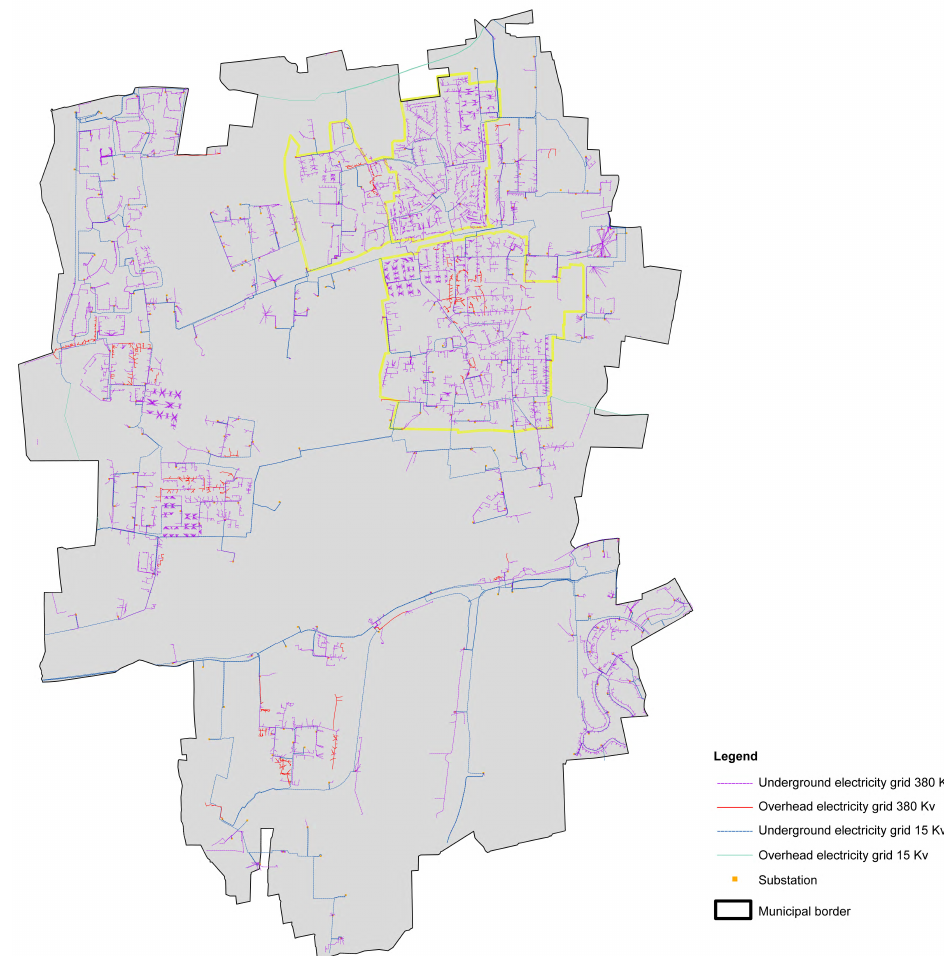
Figure 2. Underground and overhead electricity grid of Segrate Municipality. The three selected neighborhoods are highlighted (Segrate Centro, Villaggio Ambrosiano, and